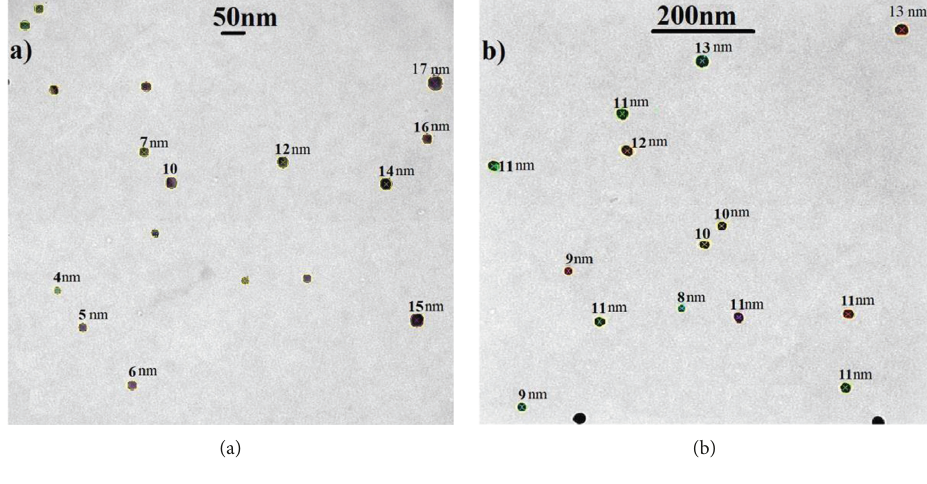
Figure 2: TEM images of vZVI. 3